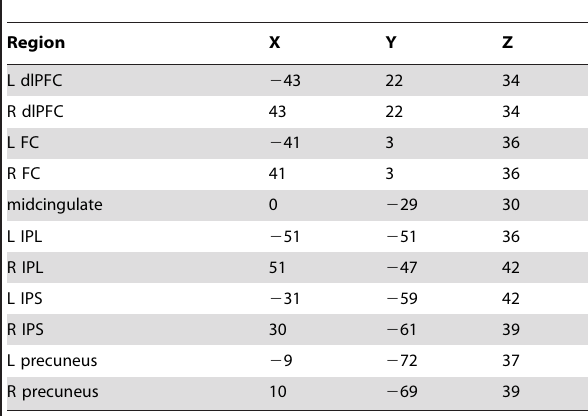
Table 2. Coordinate locations of regions in Talaraich space.